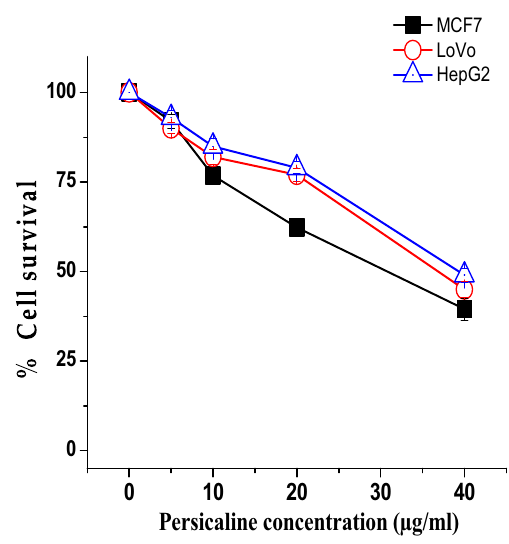
Figure 2: Cytotoxic activity of persicaline on cancer cells estimated by MTT assay. Di ff erent concentrations of persicaline were incu - bated with cells, and dimethyl sulfoxide served as the control.